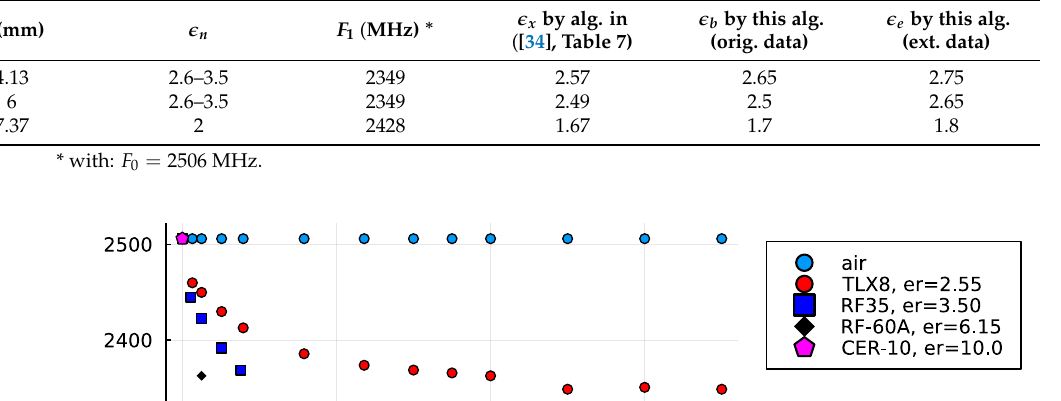
Table 4. Benchmarking three thicker samples using the RDSA proposed here.